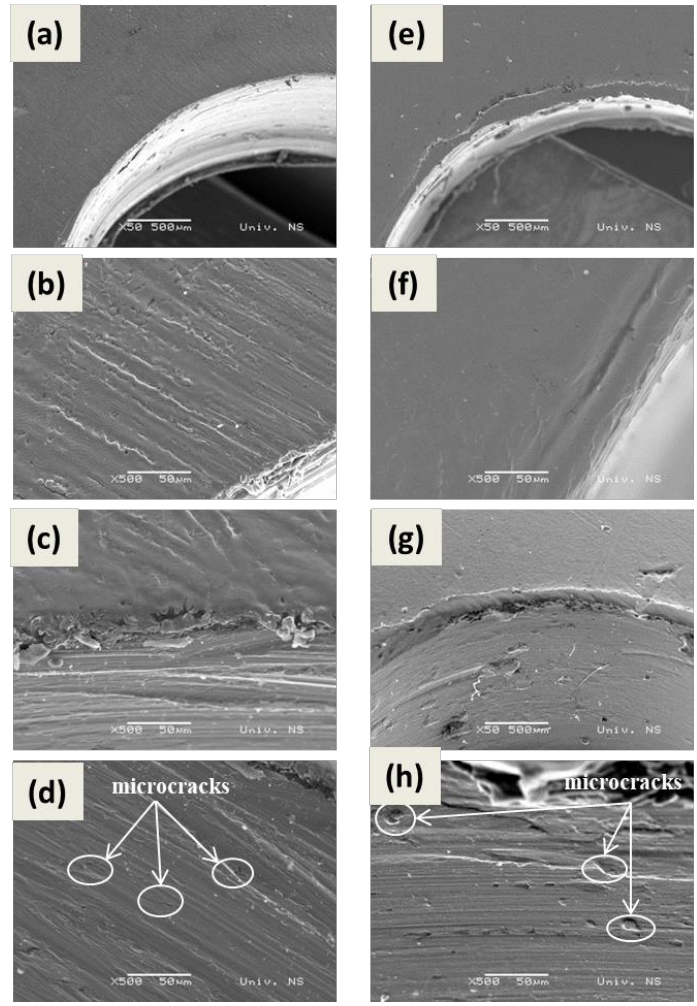
Figure 12. Micrographs after tensile test of the following: ( a – d ) material surface treated by nanosecond laser irradiation and ( e – h ) material surface treated by picosecond laser irradiation.